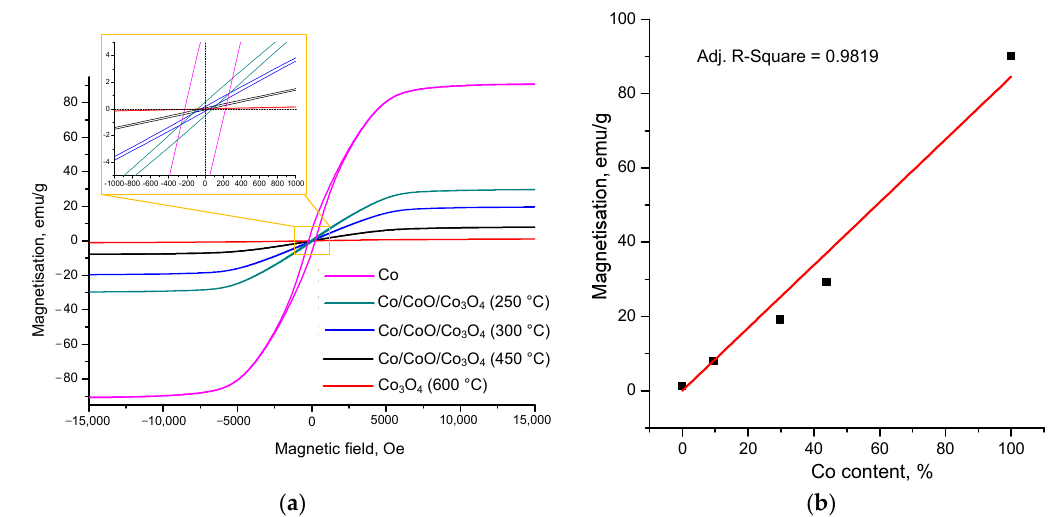
Figure 5. The dependence of saturation magnetisation of Co, Co/CoO/Co 3 O 4 and Co 3 O 4 nanoparti- cles on the magnetic field strength ( a ) and dependence of saturation magnetisation on the Co content in nanoparticles ( b ).